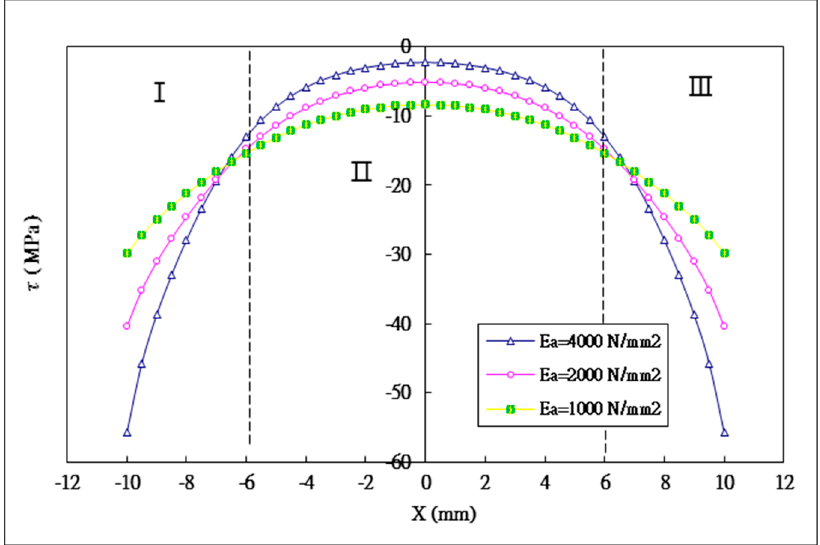
Table 4. Comparison of maximum interfacial stresses with different adhesive Young’s modulus obtained by Equation (44) and ANSYS.